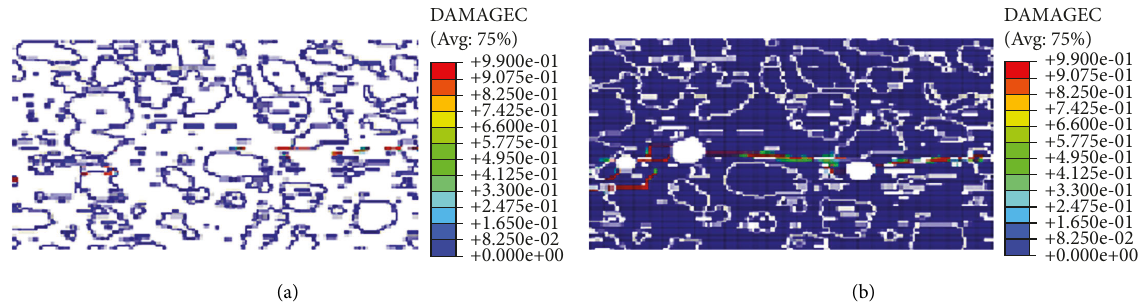
Figure 22: Local failure enlarged graph of material. (a) Interface. (b) Concrete.